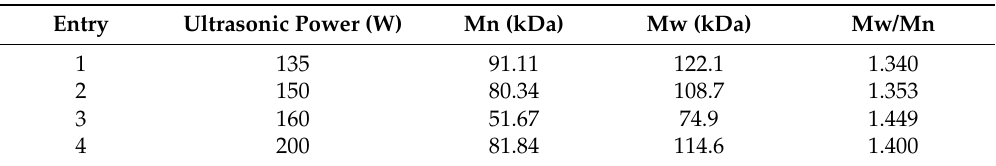
Average molecular weights and dispersity indices of LMW-HA under different ultrasonic